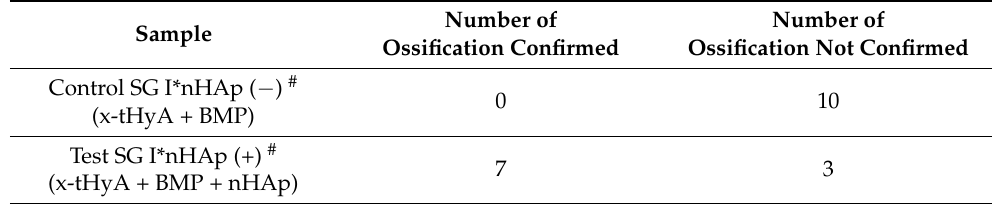
Table 3. Bone-forming numbers in the cranial subcutaneous connective tissues of mice 8 weeks after injection of 10 control SG I*nHAp ( − ) and 10 test SG I*nHAp (+) samples,